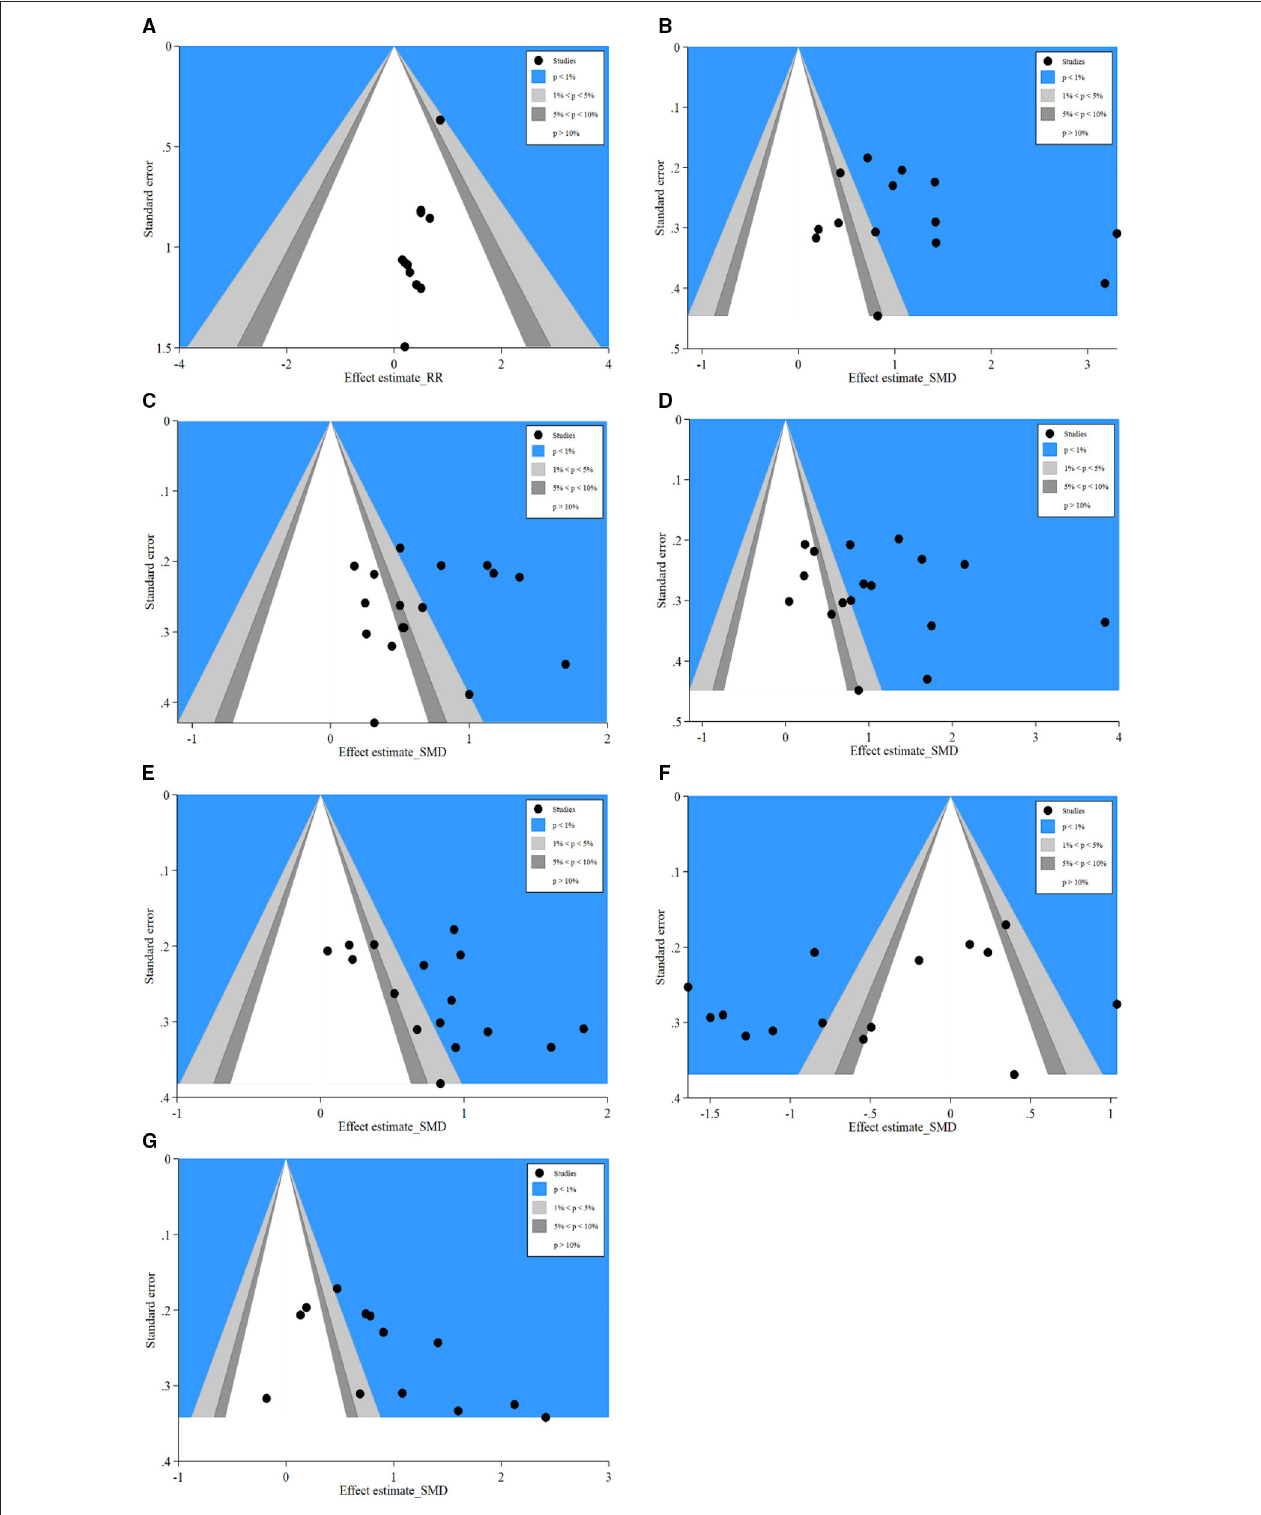
FIGURE 7 | Contour-enhanced funnel plots of SSI, IgA, IgM, IgG, CD4 + , CD8 + , and CD4 + /CD8 + . (A) Contour-enhanced funnel plot of SSI; (B) Contour-enhanced funnel plot of IgA; (C) Contour-enhanced funnel plot of IgM; (D) Contour-enhanced funnel plot of IgG; (E) Contour-enhanced funnel plot of CD4 + ; (F) Contour-enhanced funnel plot of CD8 + ; (G) Contour-enhanced funnel plot of CD4 + /CD8 + . SSI, surgical site infection.